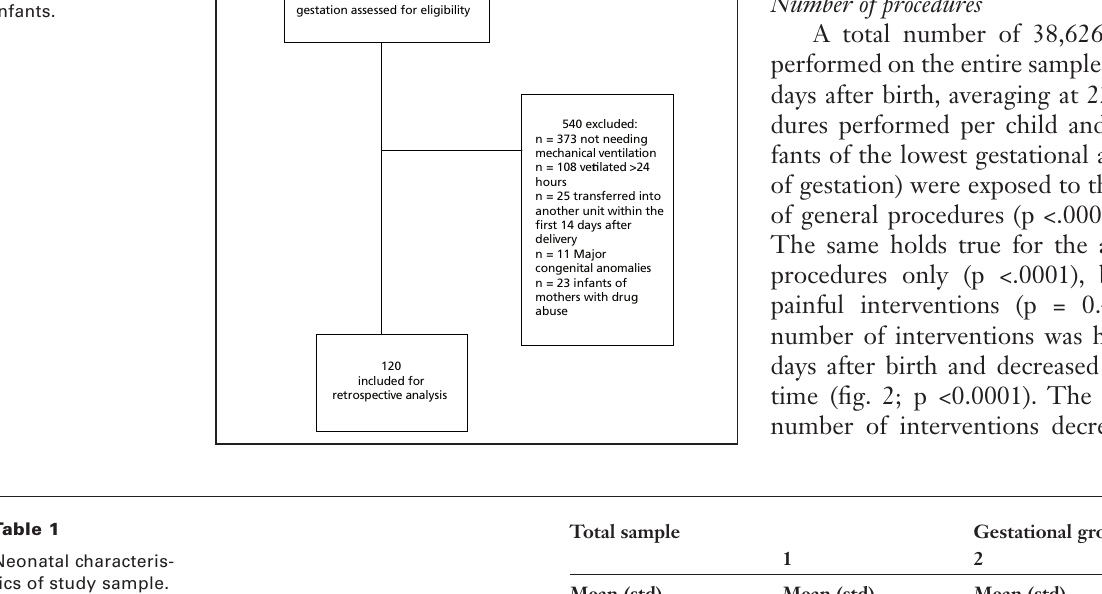
Neonatal characteris- tics of study